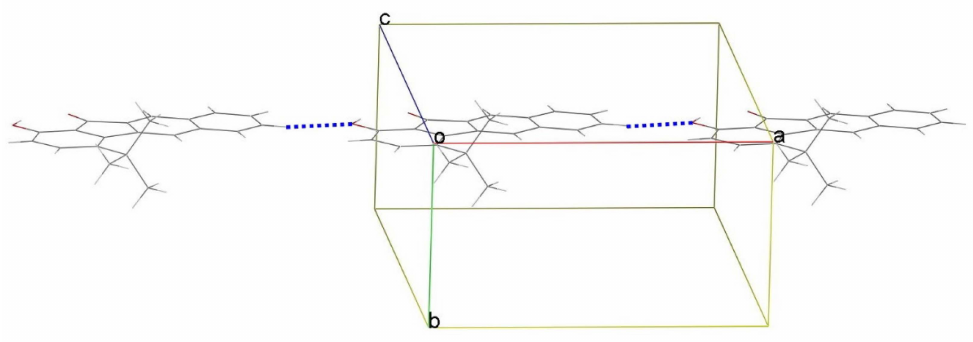
Figure 4. A packing view of 1 , viewed along the c axis. Blue dashed lines denote intermolecular C-H ¨¨¨ O hydrogen bonds.